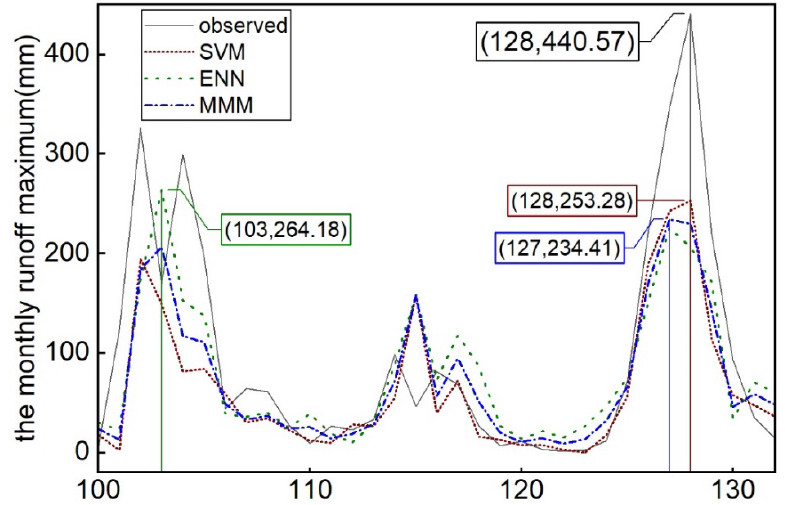
Figure 7. The monthly runoff maximum.